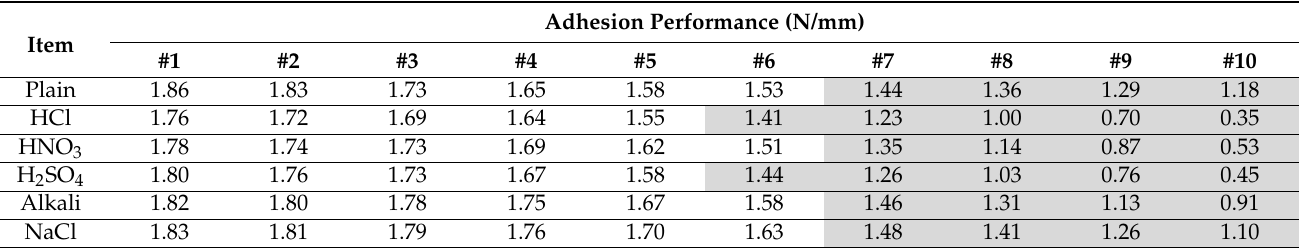
Table 10. Adhesion performance with CRC board surface.